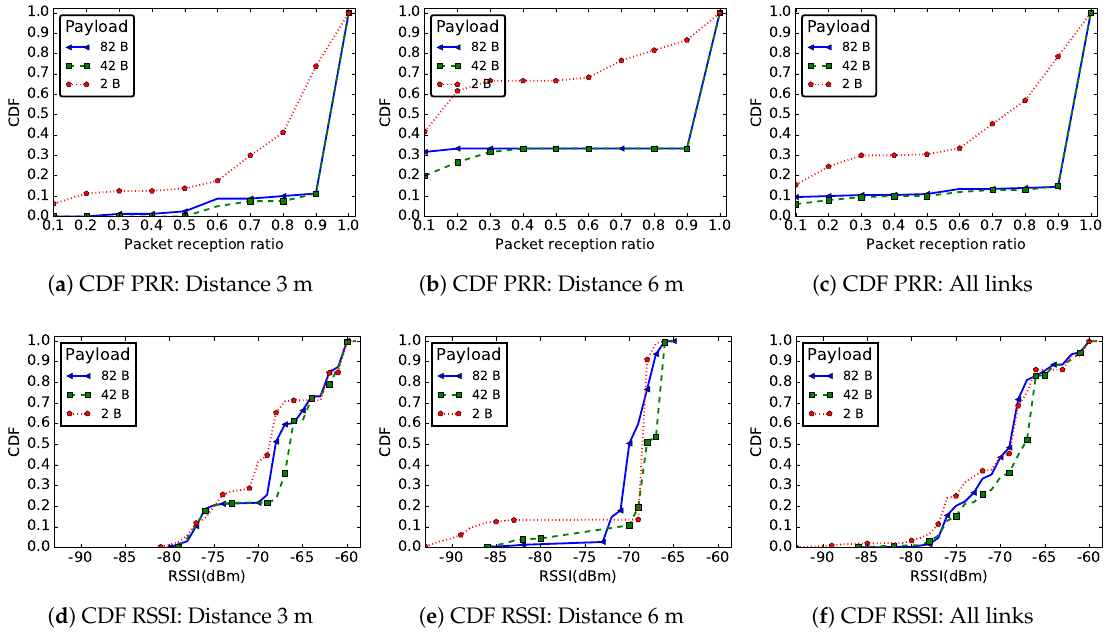
Figure 8. CDF of PRR and RSSI for distances 3 m and 6 m and for all links in the network for different packet